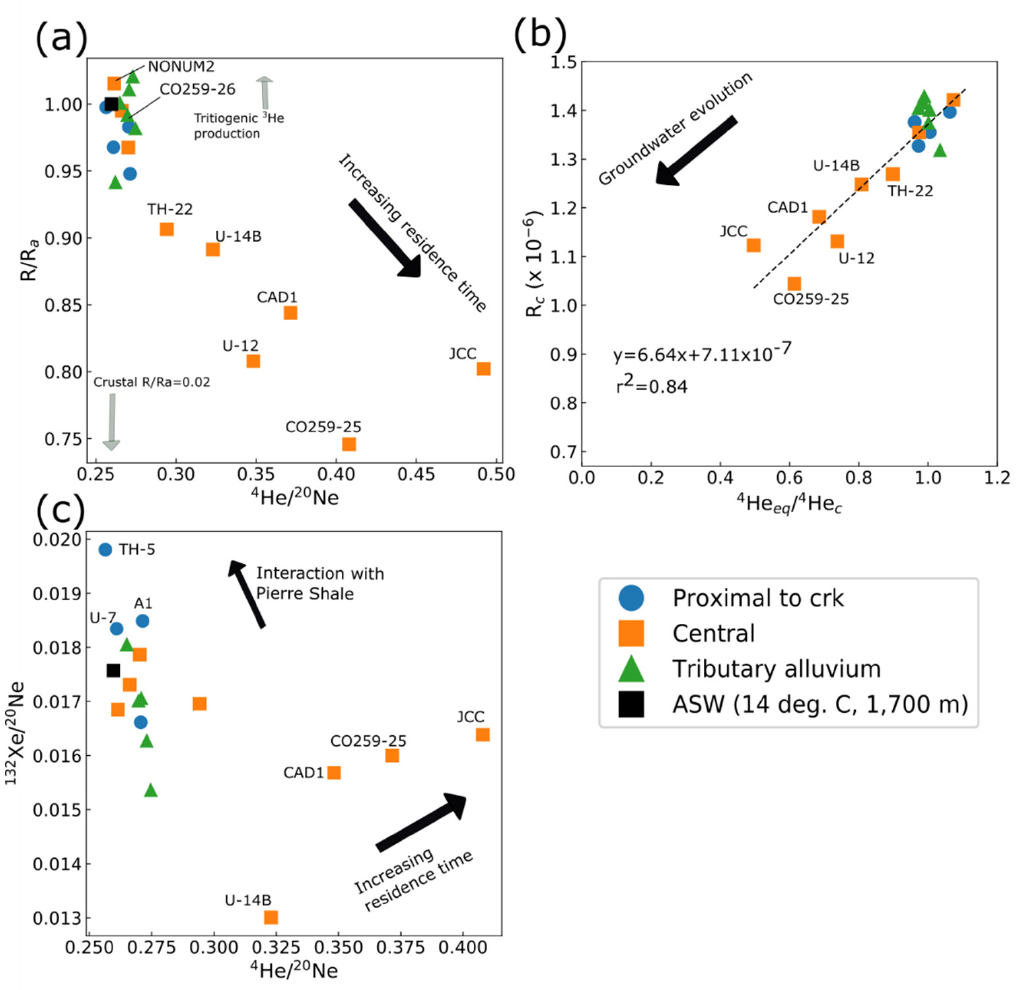
Figure 6. Noble-gas isotope compositions, namely ( a ) R/R a versus 4 He/ 20 Ne (R a = 1.4 × 10 − 6 ), ( b ) helium evolution diagram (e.g., see Reference [99]), and ( c ) 132 Xe/ 20 Ne versus 4 He/ 20 Ne. The helium evolution diagram shown in ( b ) illustrates the ratio of 3 He/ 4 He in samples corrected for air-bubble entrainment (R c ) versus 4 He derived from solubility ( 4 He eq ) over total corrected 4 He ( 4 He c ). Wells of interest are labeled with site alias, for discussion. The composition of air-saturated water (ASW) was calculated, using the method of Reference [98] and the atmospheric composition from Reference [101], solubility at 14 degrees Celsius ( ◦ C), and 1700 m above North American Vertical Datum of 1988 (NAVD88). Extents of analytical uncertainties are within the points on all